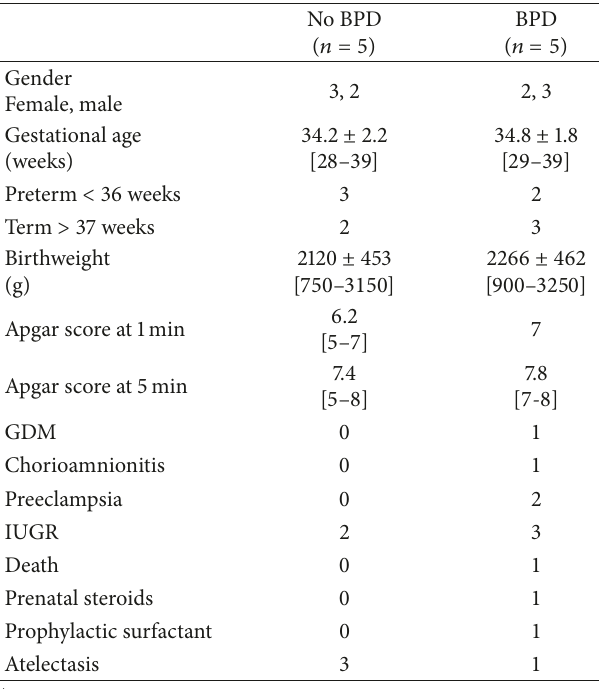
Table 1: Clinical characteristics in neonates without or with BPD ∗